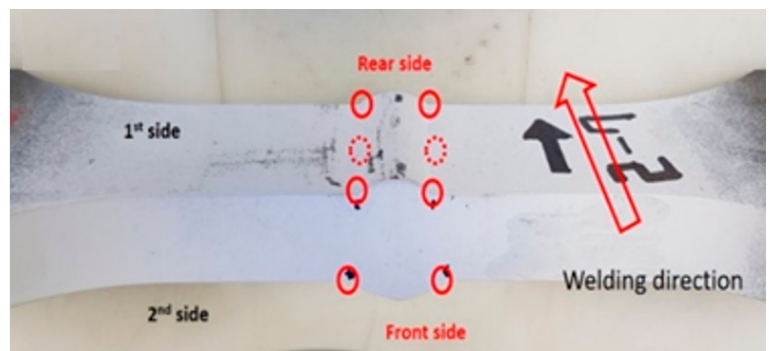
Figure 8. Locations for toe angle measurement using the template.